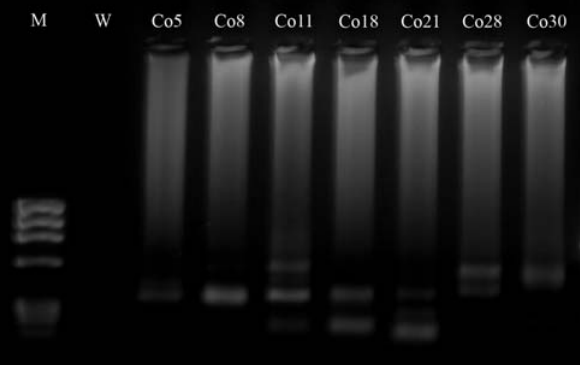
Figure 1 - Representative agarose gel showing PCR amplimers that prob- ably resulted from translocation events at 11q23 ( MLL ) in peripheral lym- phocytes of healthy individuals. M = molecular weight marker (cid:4) X 174; W = negative control; Co =